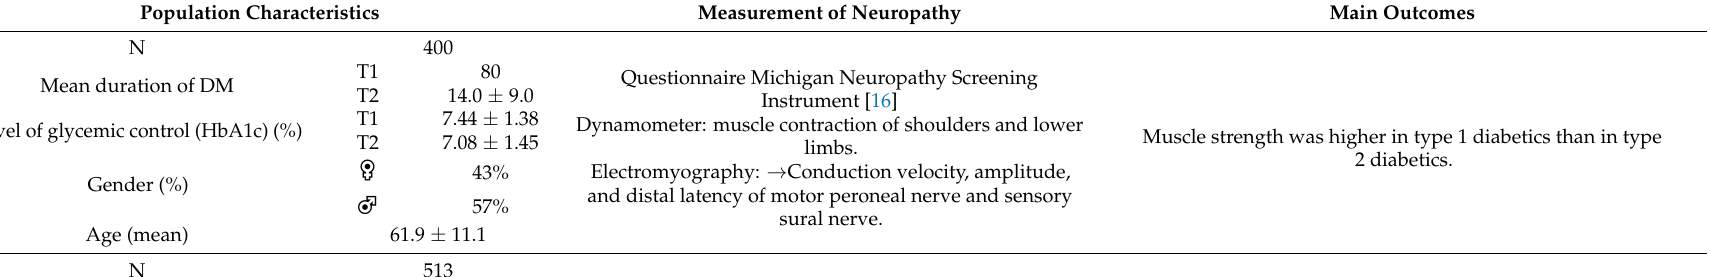
Table 1. Differences between type 1 (T1) and type 2 (T2) diabetes in sensory neuropathy. Table 2. Differences between type 1 (T1) and type 2 (T2) diabetes in motor neuropathy. Figure 1. Systematic review workflow.